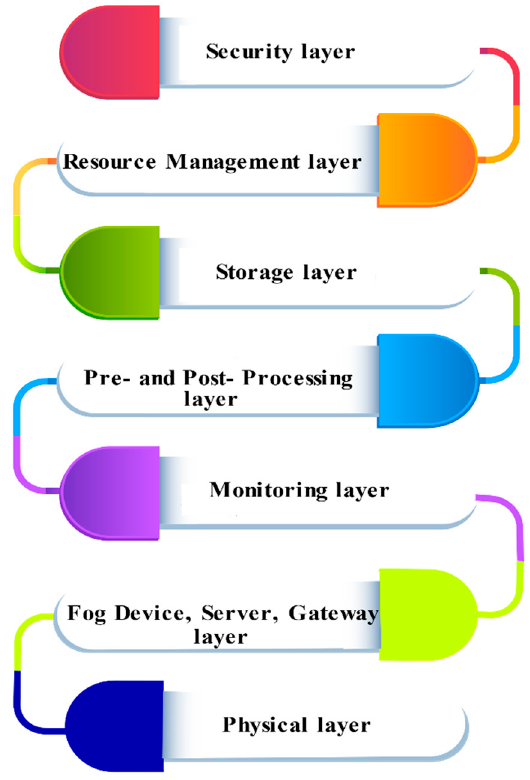
Figure 10. Typical fog computing architectural layers.